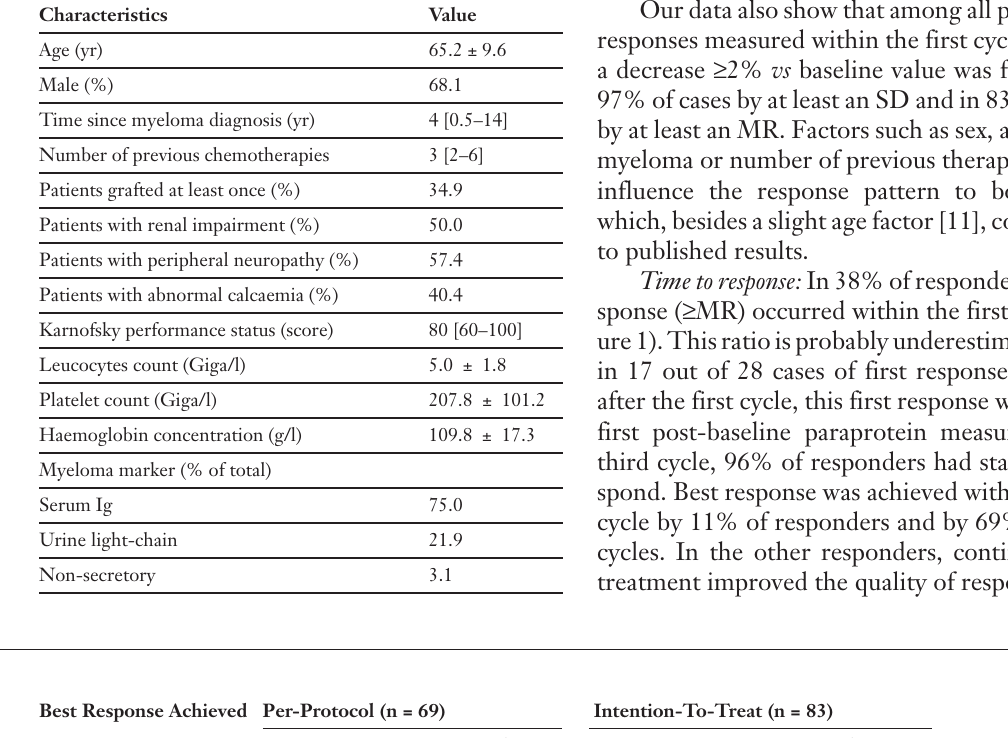
Table 3 Overall response rate (% responders vs % non-responders) and best response achieved in the per- protocol population (at least two borte- zomib cycles) and in the intention-to-treat population (at least one bortezomib injec-